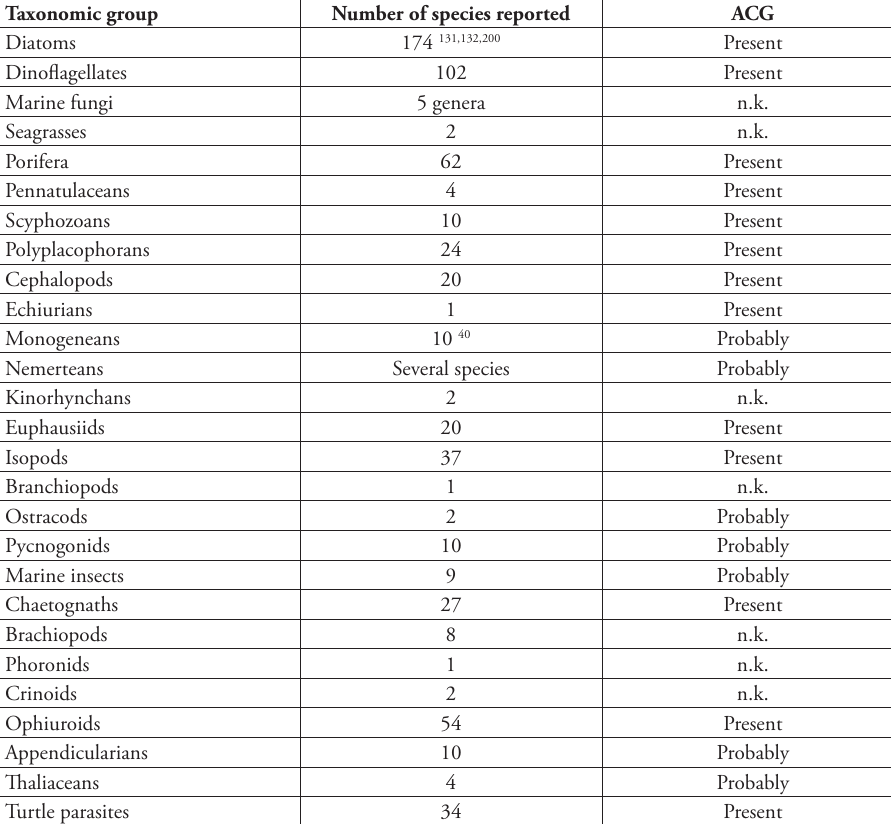
Table 4. Taxa reported from other sites of Pacific Costa Rica (see Cortés 2012, plus references indicated as superindex), but not from Área de Conservación Guanacaste. n.k. = not known; Present = have been observed or collected but there are no publications; Probably = there is a high probability that they are present but have not been observed